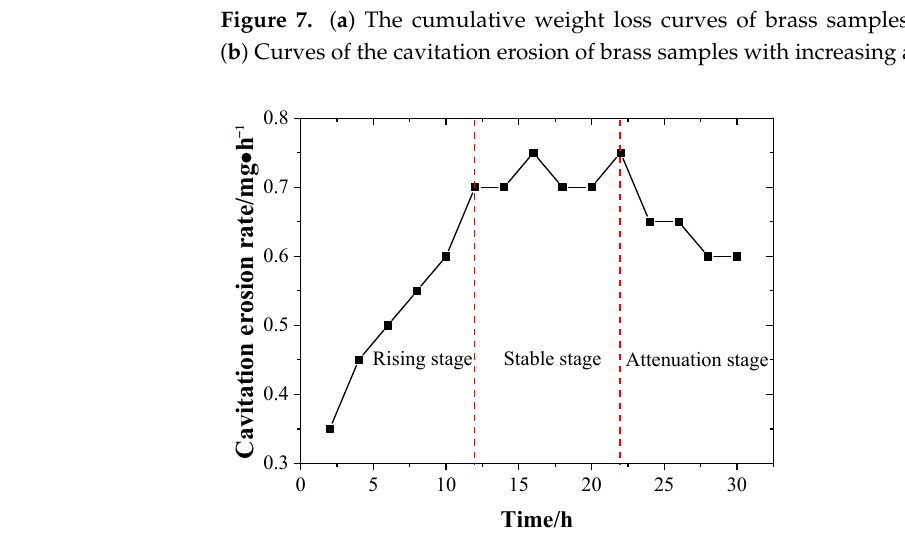
Figure 8. The developmental stage of the brass sample under increasing acting time.